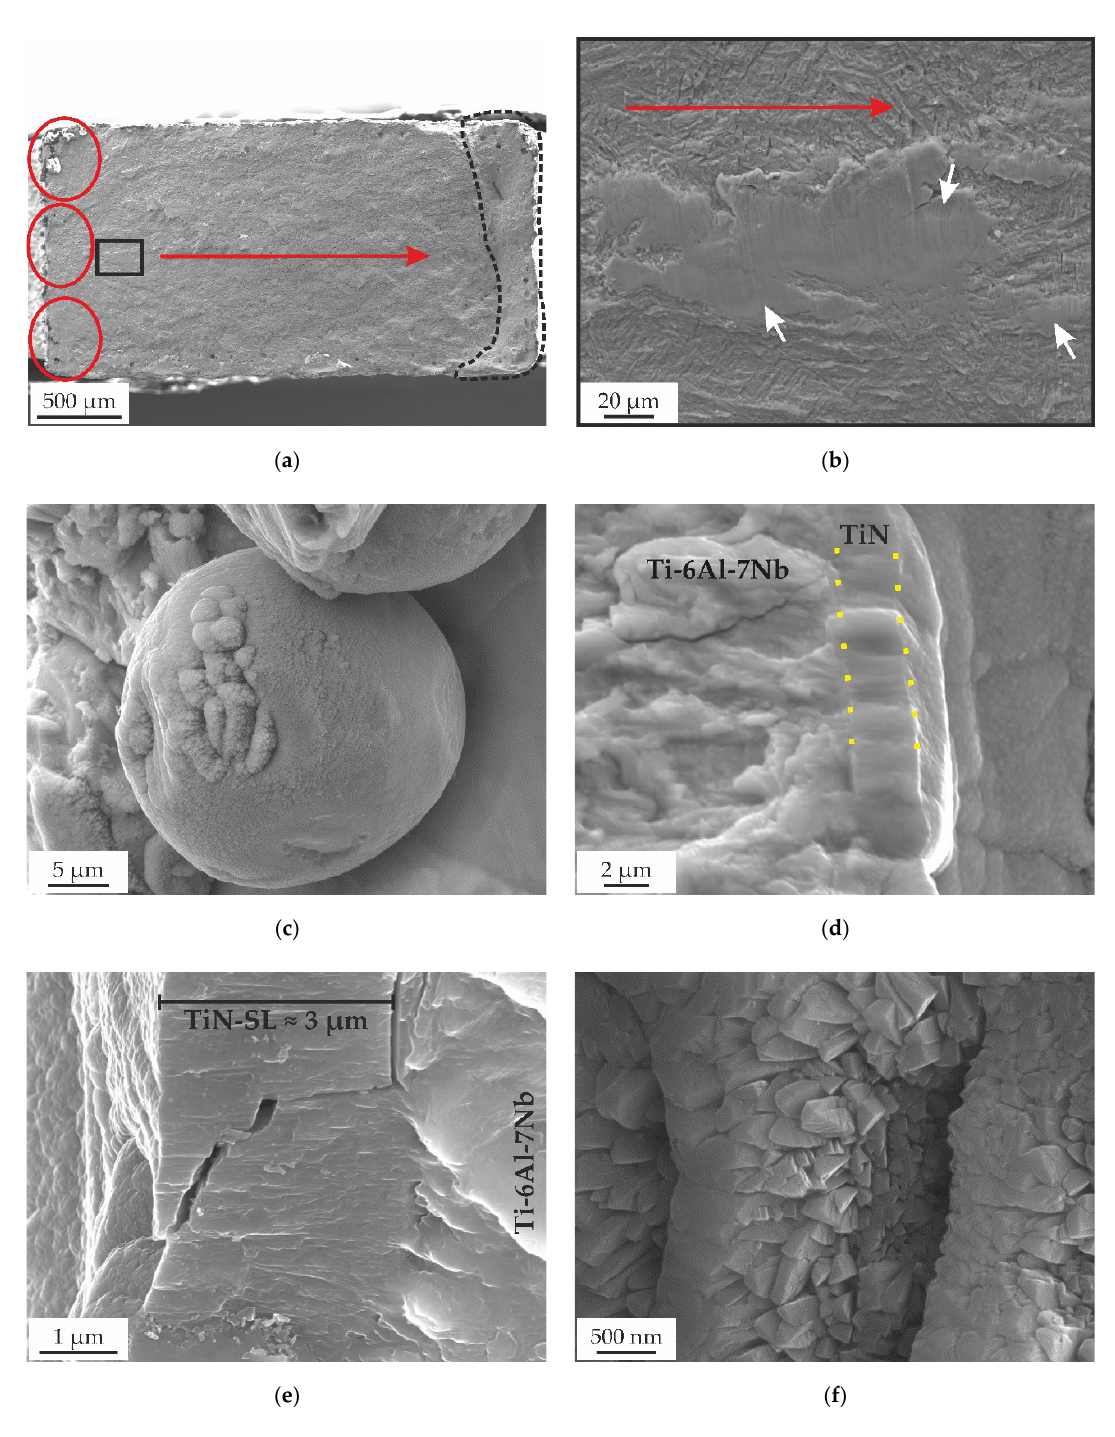
Figure 4. SEM images of the fracture surface of a TiN-coated specimen; ( a ) overview SE image of the fracture surface, forced fracture surface indicated with the dashed line, possible crack nucleation sites within the red circles, where the red arrow indicates crack propagation direction; ( b ) SE image of fracture surface from the black square in ( a ), with crack propagation direction (red arrow) and fatigue striations (white arrows); ( c ) SE image of coated powder particle on the surface of the specimen; ( d ) SE image of TiN coating (dashed, yellow lines) in the boundary region of the fatigue fracture surface of the substrate (left area); ( e ) in-lens image of TiN surface layer (TiN-SL) at the edge of a fractured surface (right area) after fatigue testing, showing emerged cracks in the coating; ( f ) in-lens image of the TiN surface with edgy and angular, pyramid-like growth structure.